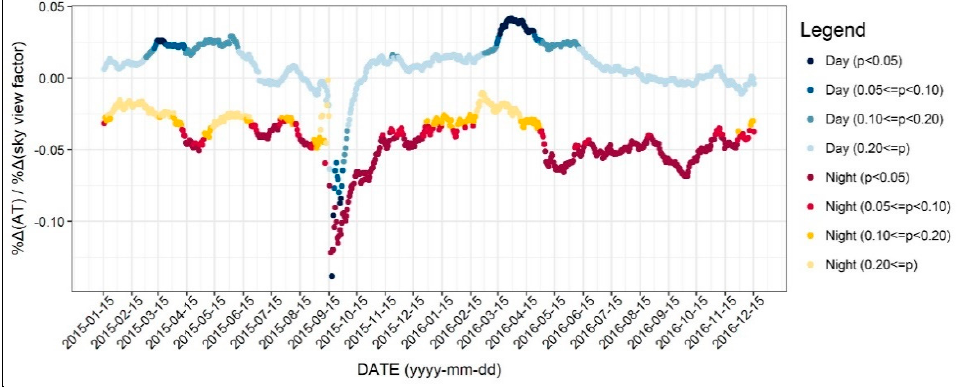
Figure 14. Changing patterns in the regression coefficients and their significances (sky view factor). Int. J. Environ. Res. Public Health 2019 , 16 , x FOR PEER REVIEW